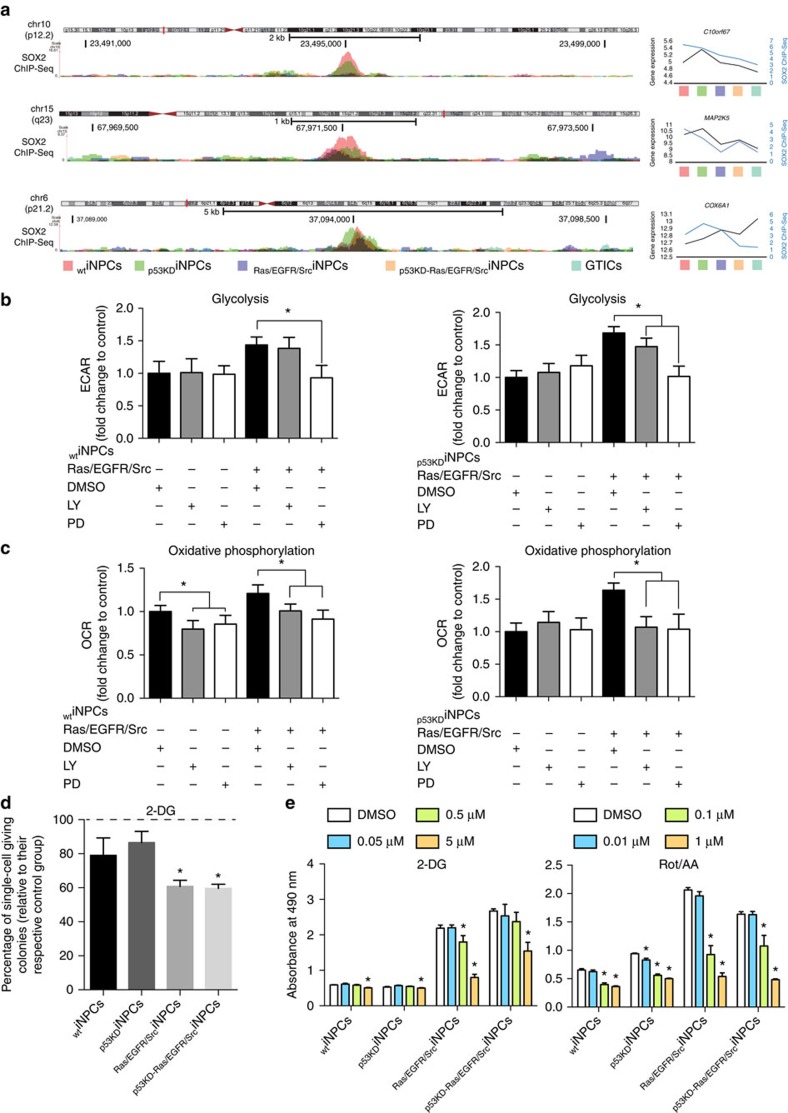
Human iNPCs transformation leads to differential SOX2 binding and metabolic reprogramming.(a) Chromatin Immunoprecipitation with SOX2 antibodies followed by deep-sequencing demonstrates differential binding of SOX2 in WTiNPCs as compared with transformed iNPCs and primary GTICs. (b,c) Modulation of PI3K and MAPK signalling pathways with LY294002 (LY) and PD098059 (PD), respectively, reverts the metabolic changes observed in transformed iNPCs as indicated by seahorse analysis. MAPK inhibition restores glycolytic activities (b), whereas inhibition of both, PI3K and MAPK, reduced oxidative phosphorylation to the levels observed in WTiNPCs (c) (n=4 group/condition with four technical replicates). (d) Inhibition of glycolysis by 2-DG compromises self-renewal properties in transformed iNPCs (n=4 group with four technical replicates). (e) Chemical induced glycolysis inhibition (2-DG) and ROS production (Rot/AA) compromises transformed iNPC viability in MTS assays (n=4 group/condition with four technical replicates). Data are represented as mean±s.d. P values were calculated by Student's t-test. *P<0.05.